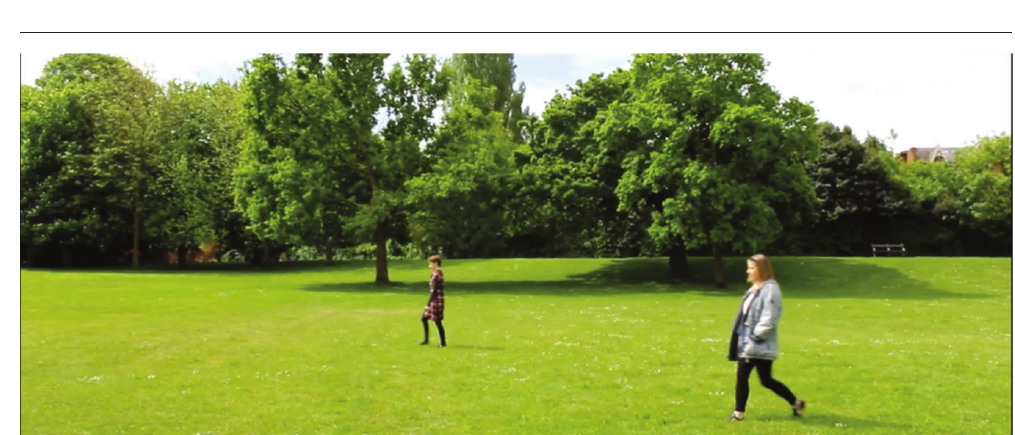
Figure 2: Still from Open Arms , Birkenhead Sixth Form College students, 2015: exploring